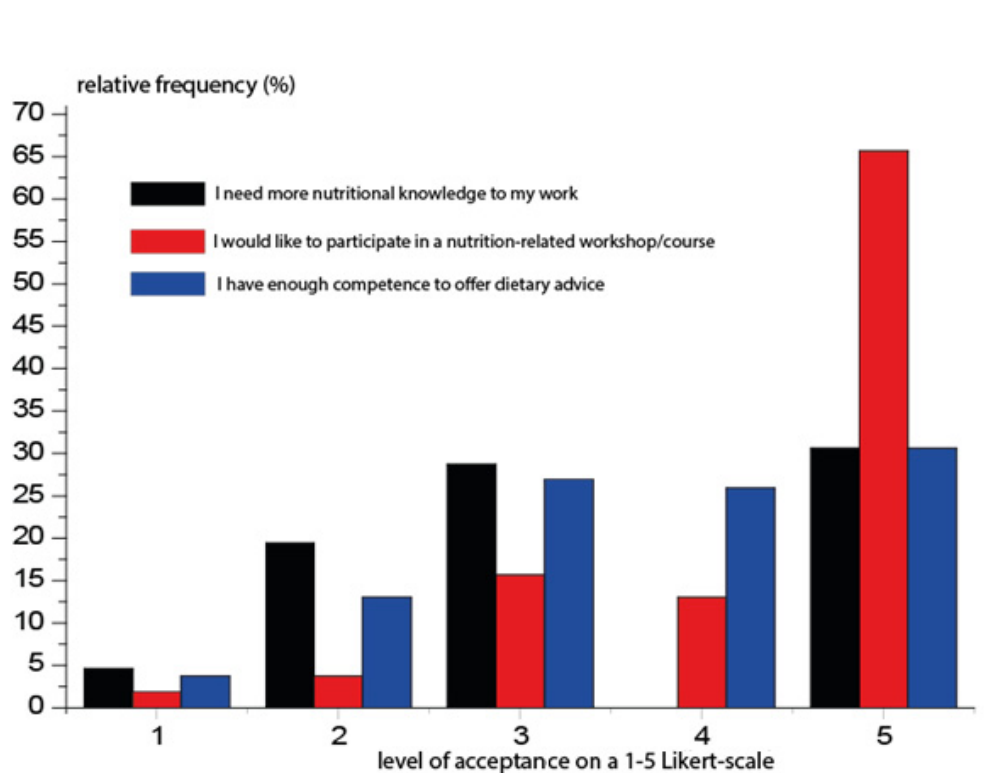
Figure 3. Attitudes of trainers to nutrition-related knowledge.